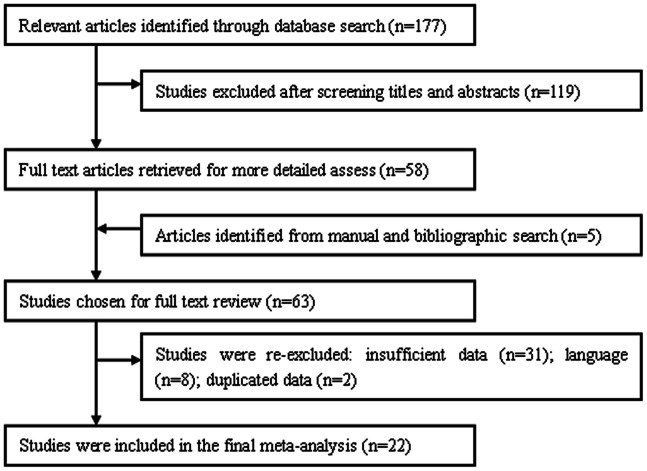
Flow diagram of the selection and screening process for eligible studies.